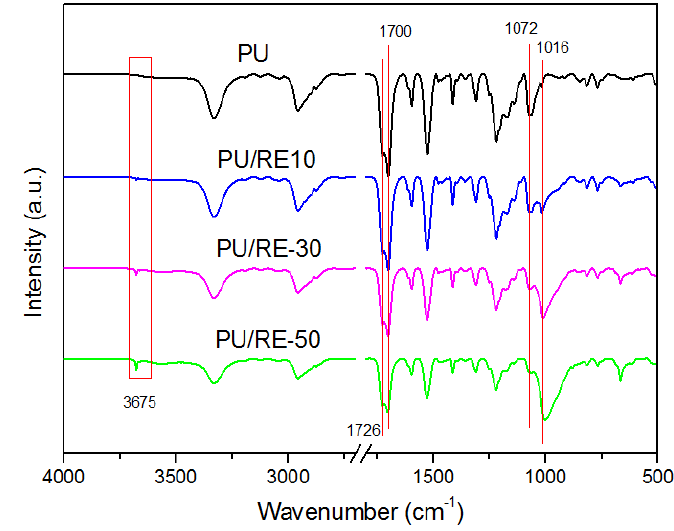
Figure 6. FTIR spectra of different PU/RE nanofibrous mats.